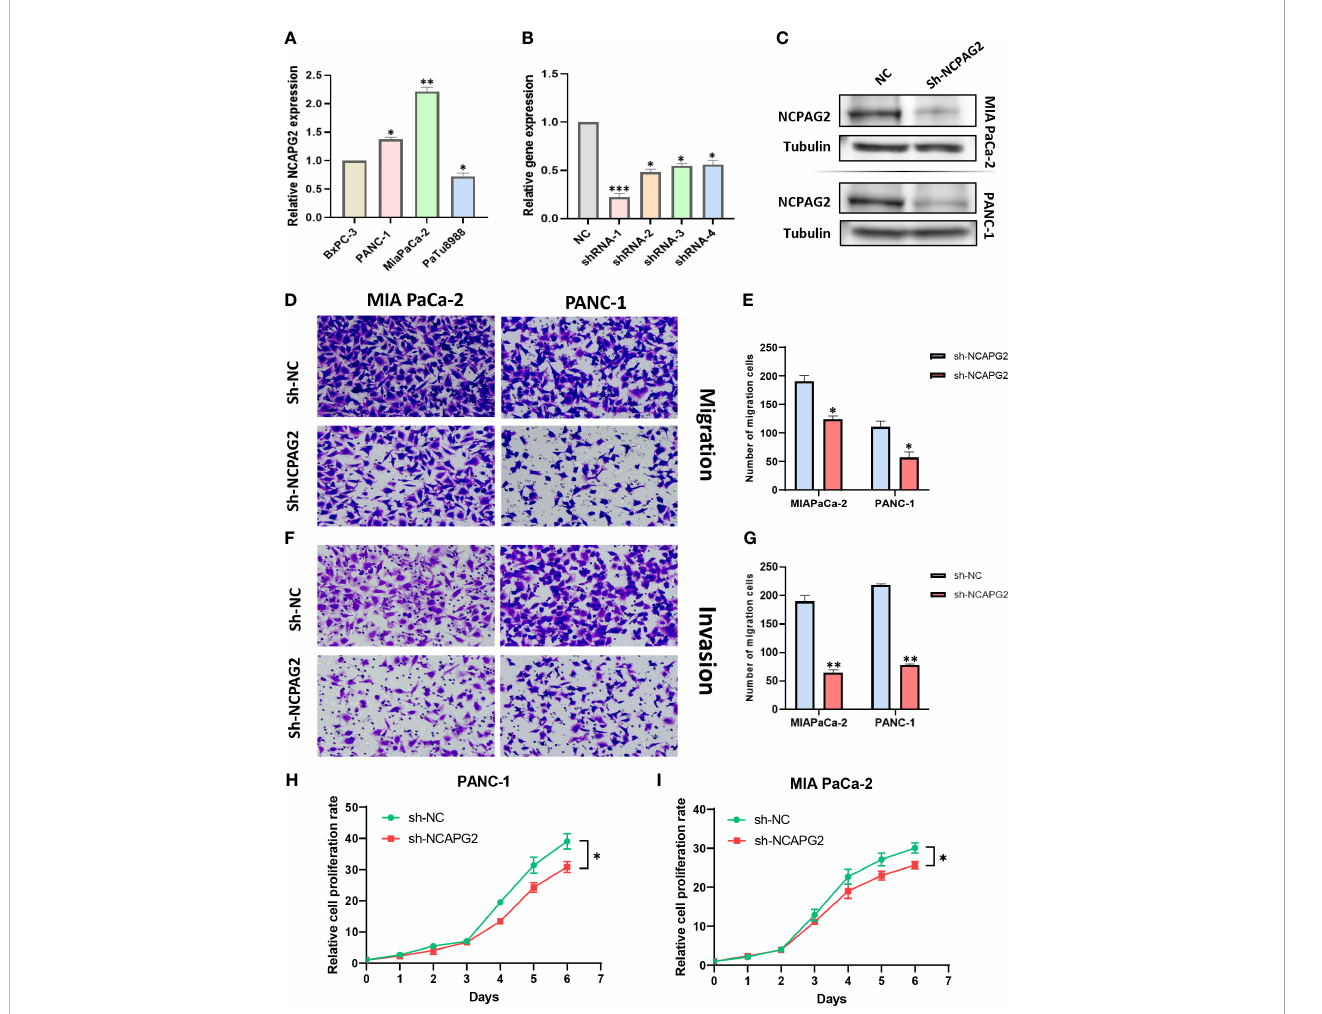
FIGURE 9 The effect of sh-NCAPG2 on the proliferation, invasion and metastasis of pancreatic cancer cells. (A) Relative mRNA expression of NCAPG2 in PC cell lines (B) and Weston blotting (C) determine the ef fi ciency of sh-NCAPG2 in PC cells. (D, F) Migration and invasion of cells were detected employing the tranwell assay. (E, G) Histogram showing the number of migrating and invading cells,the error bars of the histograms indicate the SD of the three measurements. (H, I) CCK8 assay to detect the proliferative capacity of pancreatic cancer cells. *p< 0.05; **p<0.01;